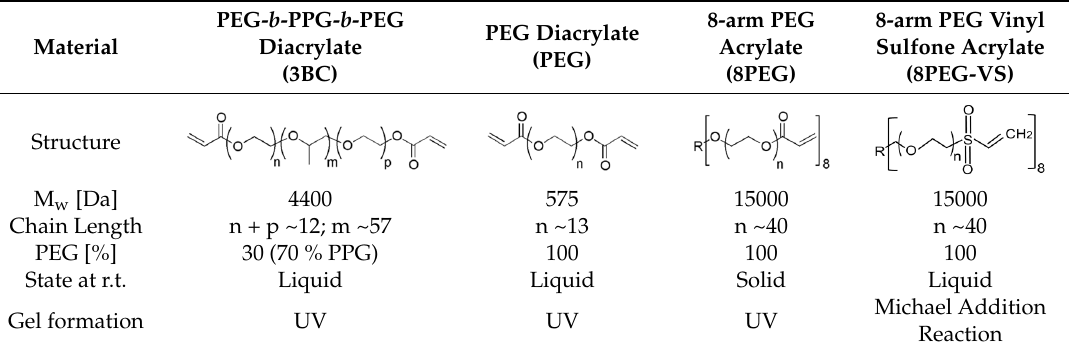
Table 1. Physicochemical properties of PEG-based precursors: PEG-PPG-PEG (3BC), PEG Diacrylate Table 1 . Physicochemical properties of PEG-based precursors: PEG-PPG-PEG (3BC), PEG Diacrylate Table 1 . Physicochemical properties of PEG-based precursors: PEG-PPG-PEG (3BC), PEG Diacrylate Table 1 . Physicochemical properties of PEG-based precursors: PEG-PPG-PEG (3BC), PEG Diacrylate Table 1 . Physicochemical properties of PEG-based precursors: PEG-PPG-PEG (3BC), PEG Diacrylate (PEG), 8arm PEG acrylate (8PEG) and 8arm PEG Vinyl Sulfone (8PEG-VS). Values are obtained from (PEG), 8arm PEG acrylate (8PEG) and 8arm PEG Vinyl Sulfone (8PEG-VS). Values are obtained from (PEG), 8arm PEG acrylate (8PEG) and 8arm PEG Vinyl Sulfone (8PEG-VS). Values are obtained from (PEG), 8arm PEG acrylate (8PEG) and 8arm PEG Vinyl Sulfone (8PEG-VS). Values are obtained from (PEG), 8arm PEG acrylate (8PEG) and 8arm PEG Vinyl Sulfone (8PEG-VS). Values are obtained from the manufacturer. R: hexaglycerin core structure, r.t: room the manufacturer. R: hexaglycerin core structure, r.t: room temperature. the manufacturer. R: hexaglycerin core structure, r.t: room temperature.